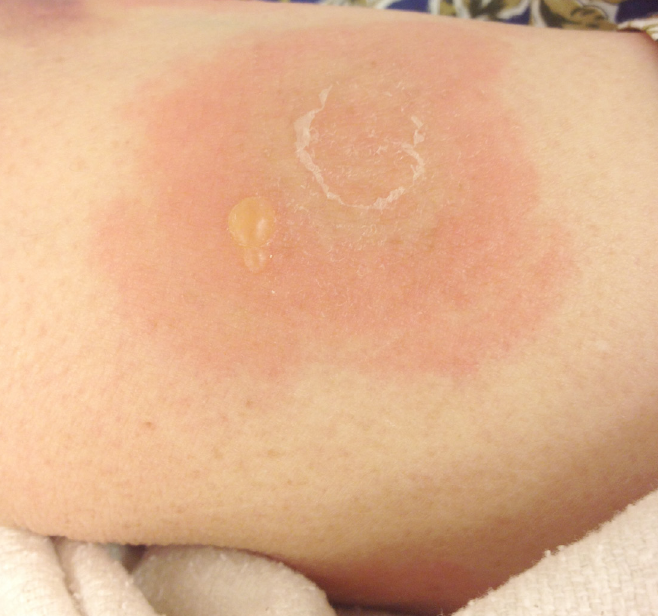
Figure 2. Skin findings include tense bullae on erythematous bases and urticaria on the right inner thigh.